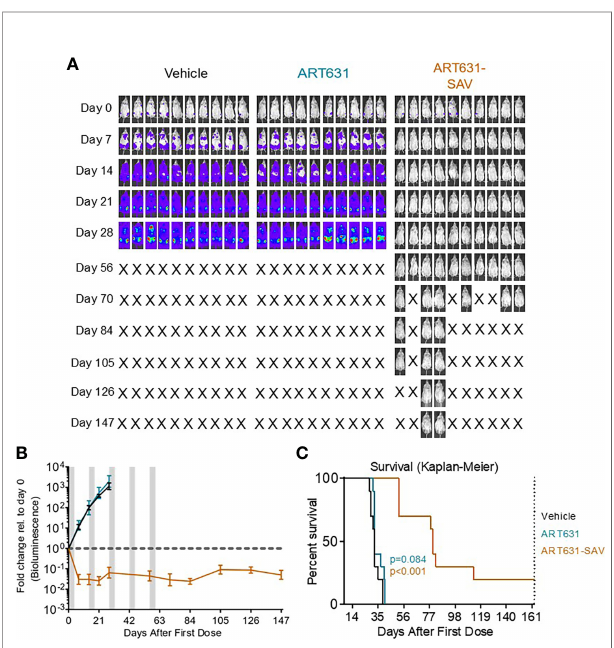
FIGURE 7 | VEN plus SOR plus ART631 induced deep, long remissions in AML xenografts. (A) SAV MTD cyclic drug treatment schema. (B) NRG mice were transplanted IV with Luc-labeled MV4;11 cells on day -10. After Xenogen quanti fi cation of baseline total body luminescence on day 0, mice were placed into balanced experimental groups prior to drug administration via gavage, then treated per our previously established MTD PO x 5 day schedule (5 days on, 9 days off). Mice were treated with 15 mg/kg/d ART631 as monotherapy or in combination with 150 mg/kg/d VEN and 30 mg/kg/d SOR for 5 identical 5-day treatment cycles over 10 weeks. These xenograft experiments with ART631 and ART631-containing SAV were performed simultaneously with those with ART838 and ART838-containing SAV reported previously (20). Treatment response outcomes were measured by (C) leukemia response quantitation (fold-change in leukemia burden on day 7 (and later) vs day 0 for each mouse via Xenogen imaging (grey-shaded bands on graphs indicate days when mice were treated). Error bars represent SD of fold-change in leukemia burden of mice in each treatment group. (D) shows corresponding Kaplan-Meier survival curves. Mouse deaths empirically de fi ned to have occurred for reasons other than leukemia (i.e. deaths of mice with luminescence at or below average background luminescence (5.7x10 5 photons/mouse based on intensity values from non-leukemia bearing mice) were censored. Comparisons between treatment groups were calculated by log-rank (Mantel-Cox) test.